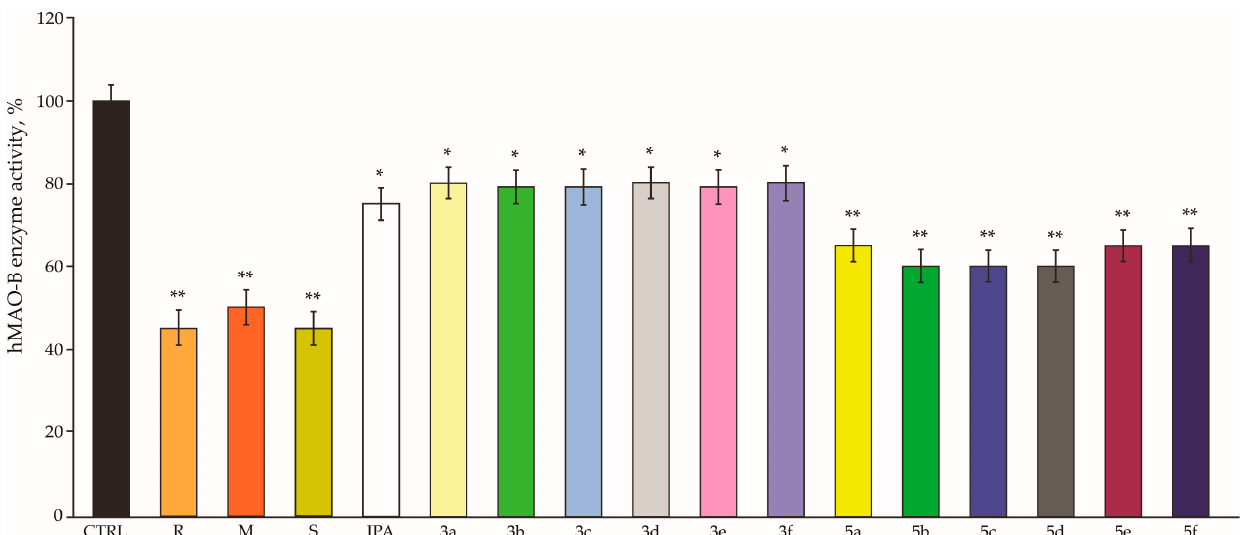
Figure 9. E ff ects of the compounds, IPA, rasagiline (R), melatonin (M) and selegiline (S), Figure 9. Effects of the compounds, IPA, rasagiline (R), melatonin (M) and selegiline (S), administered administered alone at a concentration of 1 µM, on hMAO-B enzyme activity. * p < 0.05; ** p < 0.01 alone at a concentration of 1 µ M, on hMAO-B enzyme activity. * p < 0.05; ** p < 0.01 vs. controls vs. controls (pure hMAO-B). (pure